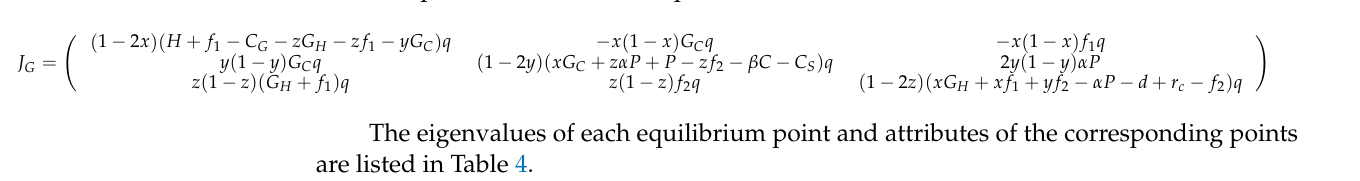
Table 4. Attribute analysis of evolutionary equilibrium points. Equilibrium Point